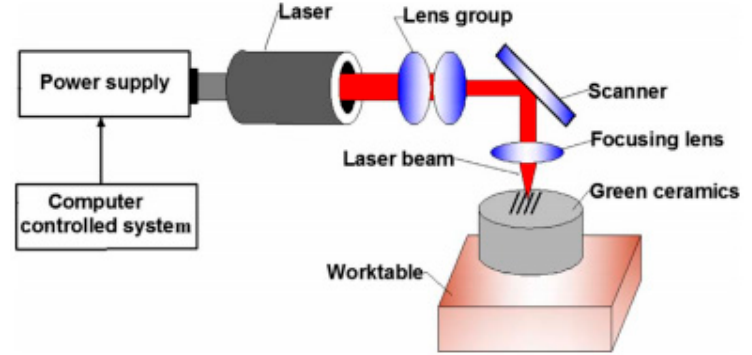
Figure 1. Representational illustration of laser surface texturing of green ceramic [22]. Reprinted from [22]. Copyright from Elsevier 2009.